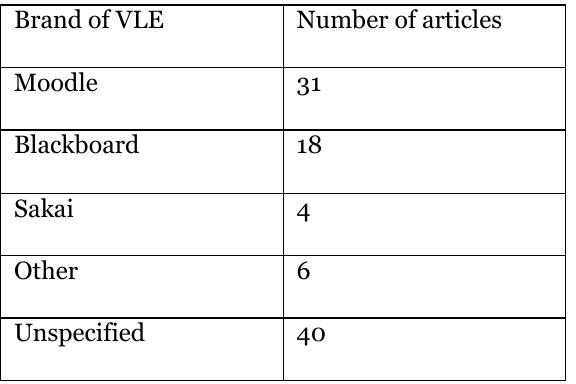
Specific Virtual Learning Environments (VLEs) Used in the